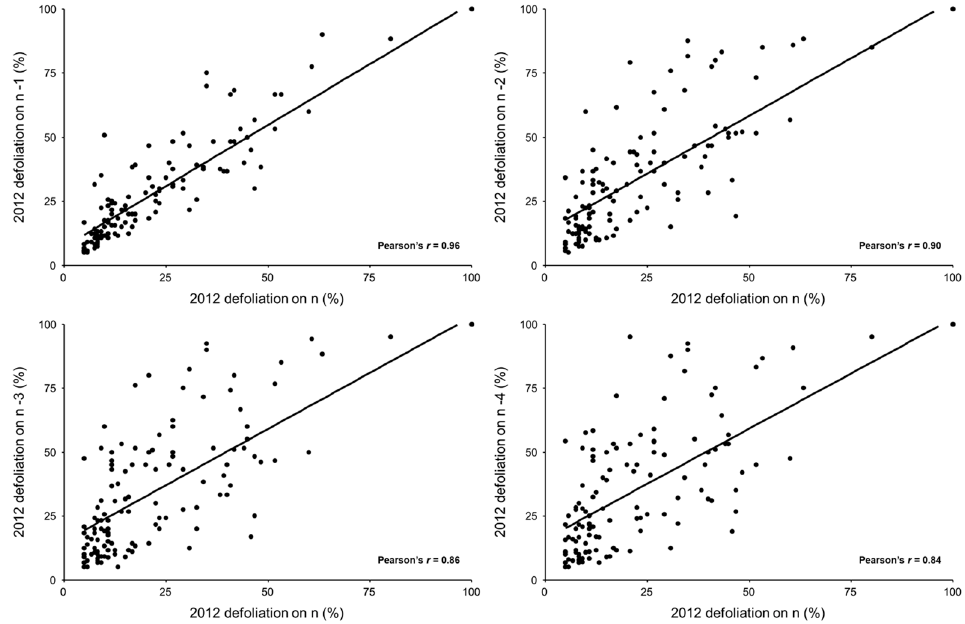
Figure 3. Relationships between defoliation on the current-year vs. previous-year shoots (n-1 to n-4) for the first year (2012) of the hemlock looper outbreak, as assessed using the field Fettes method.